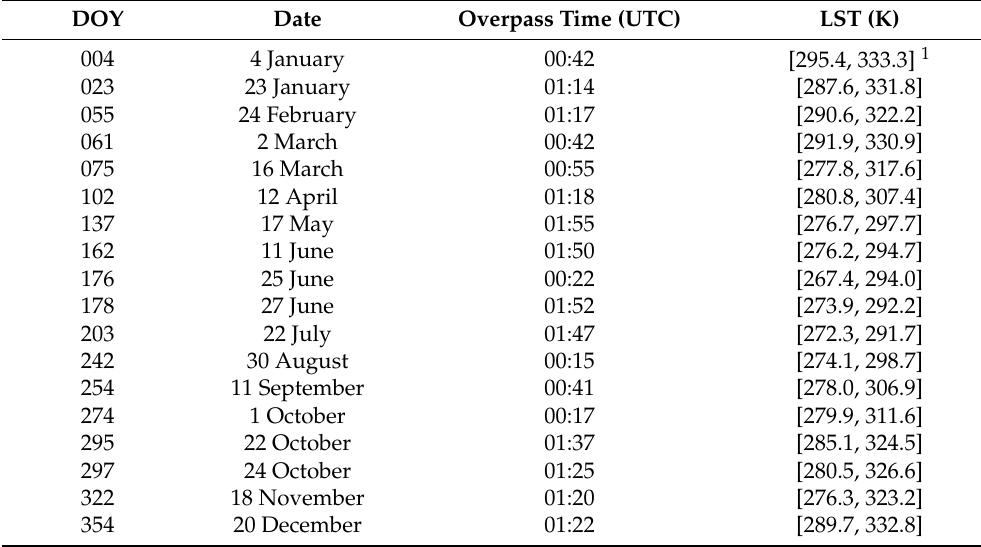
Table 1. Details of Moderate Resolution Imaging Spectroradiometer (MODIS) images for 18 days in